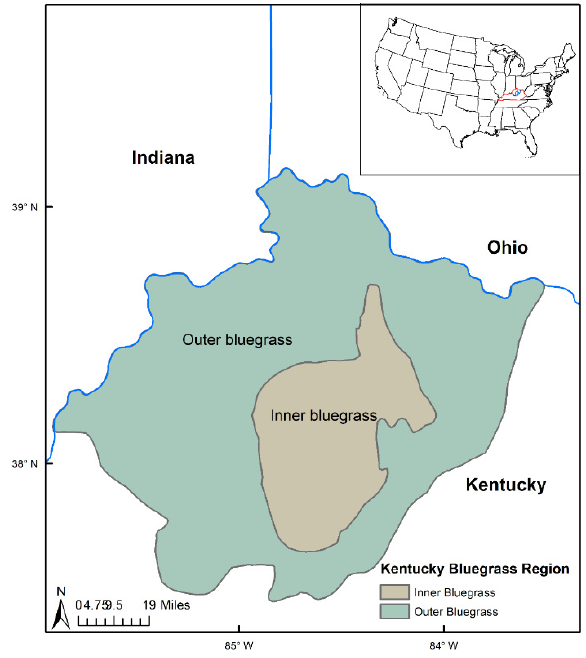
Figure 1. Map of the Kentucky Bluegrass Region.